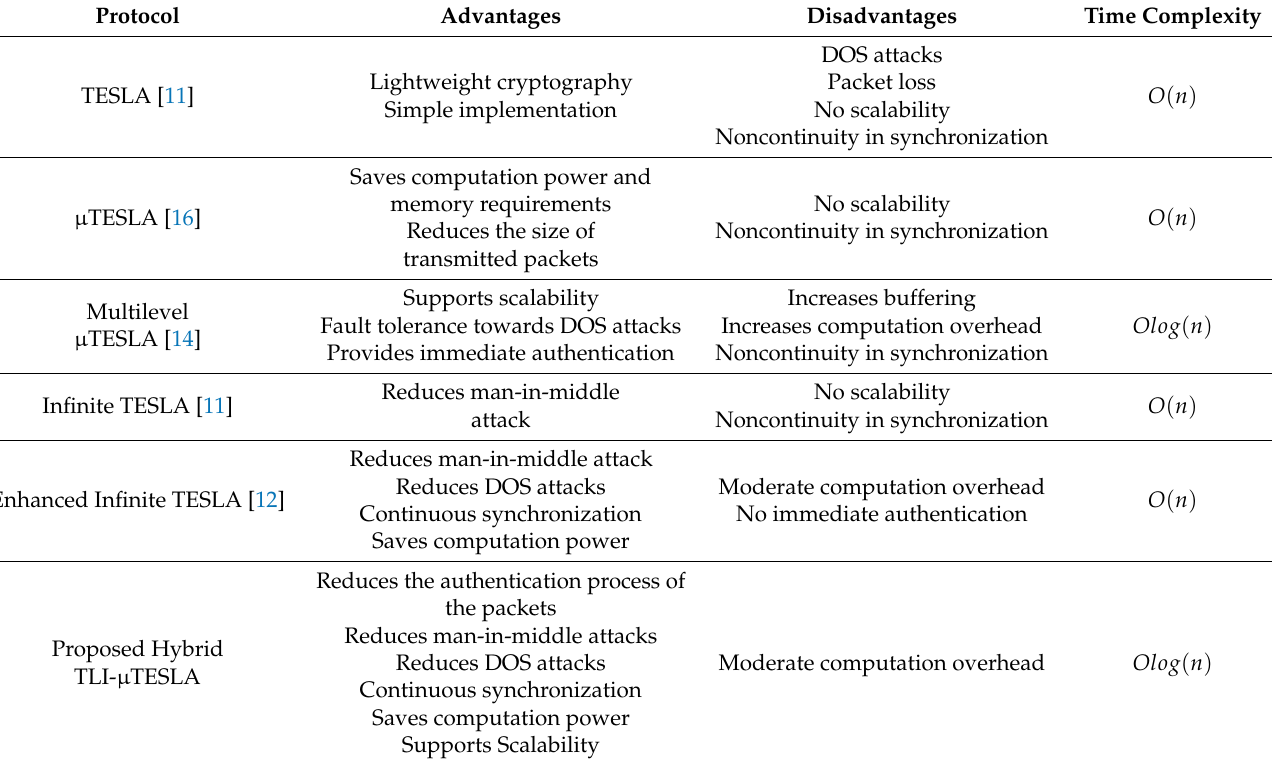
Table 1. Comparison of Various TESLA